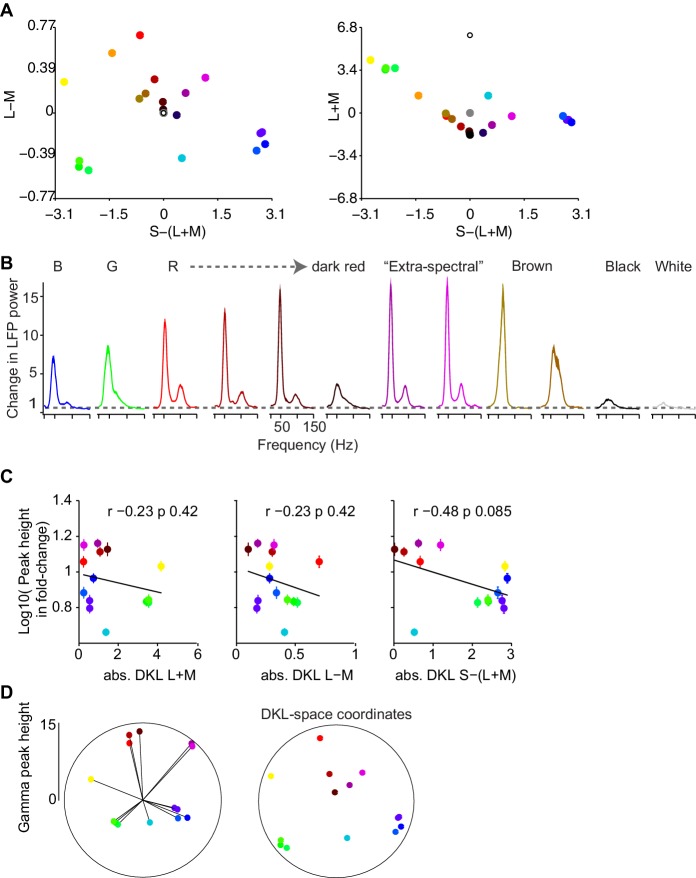
Dependence of gamma LFP power on the surface hue: additional analyses in relation to main Figure 4A.(A) Representation of hues used for Figure 4A in DKL space. (B) LFP power spectra as in Figure 4A, for additional hues. The pure blue, green and red stimuli are shown for reference, followed by red surfaces of decreasing luminance and the brown surface stimuli. See Supplementary file 1 for CIE and luminance values. (C) Correlations of gamma-band amplitude (log10 of peak height estimate) with absolute cone contrasts in DKL space were not significant, with trends for negative correlation values. Log-transformed values were used to reduce the effects of outliers on correlations. The pattern was similar across monkeys, with monkey A showing a significant, negative correlation of absolute S-(L + M) value to peak height (p=0.039 corrected for multiple comparisons within but not across animals). (D) Gamma peak height as a function of angle in the DKL plane. Angles were obtained by normalizing the L-M and S-(L + M) axes to the maximum absolute value for each respective axis. The resultant vector length was at an angle of 73.95 deg (where 90 deg is defined as maximum L-M contrast and no S-(L + M) contrast) and significantly clustered (resultant length = 0.33, p<0.001, permutation test). The panel on the right shows the DKL space coordinates of the colors used in the left panel.